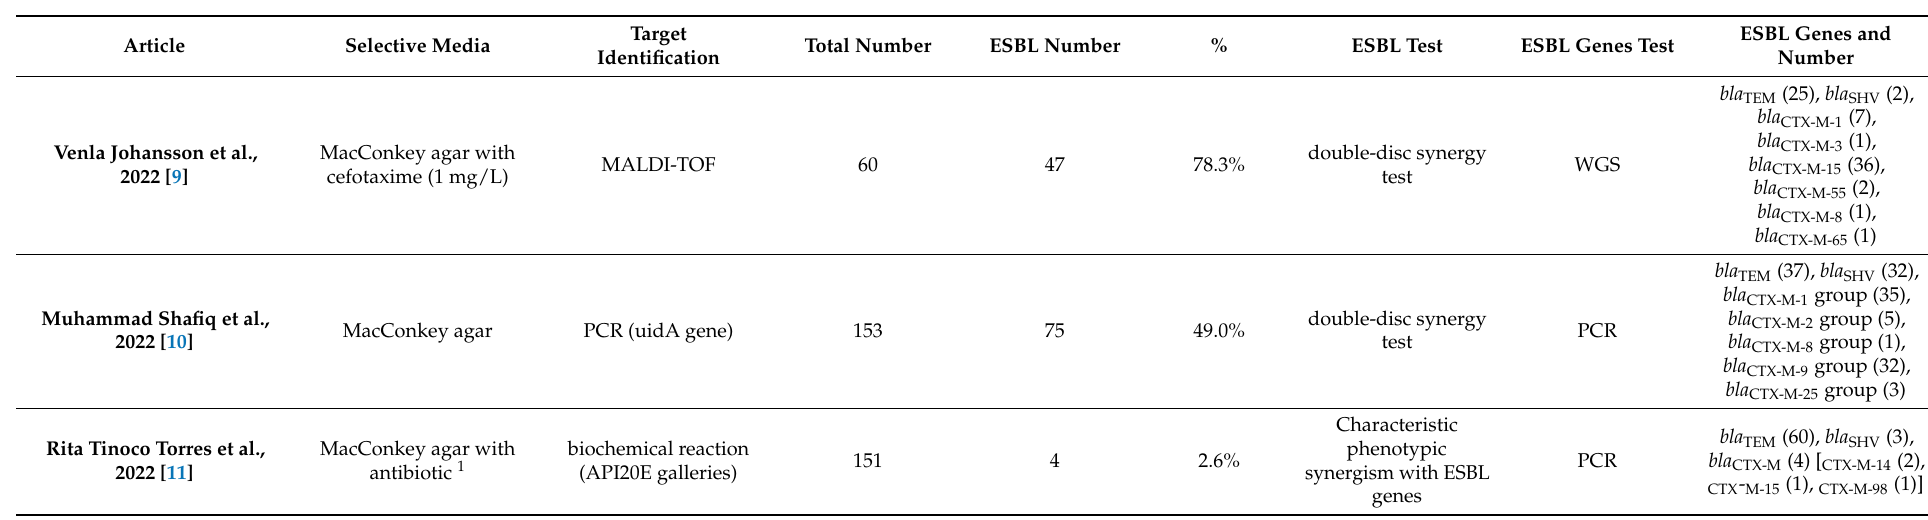
Table 2. Characteristics of ESBL genes in animals in the